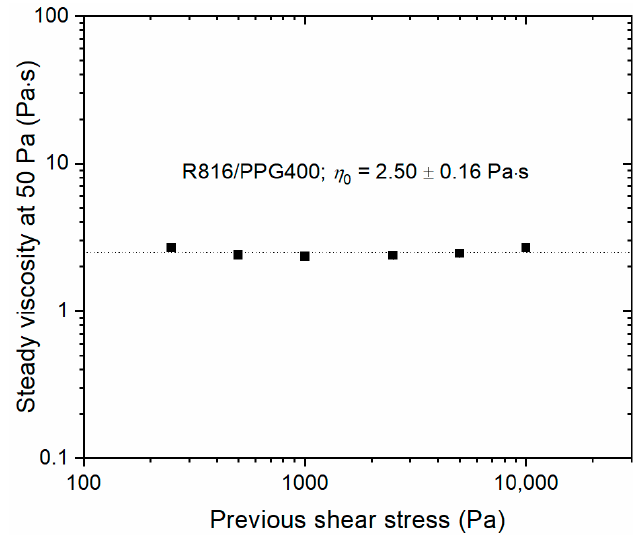
Figure 3. Steady viscosity at 50 Pa of the R816/PPG400 suspension after sheared at different stresses. The figure shows the microstructure of the sample maintains reversible when is stressed at τ i ≤ 10,000